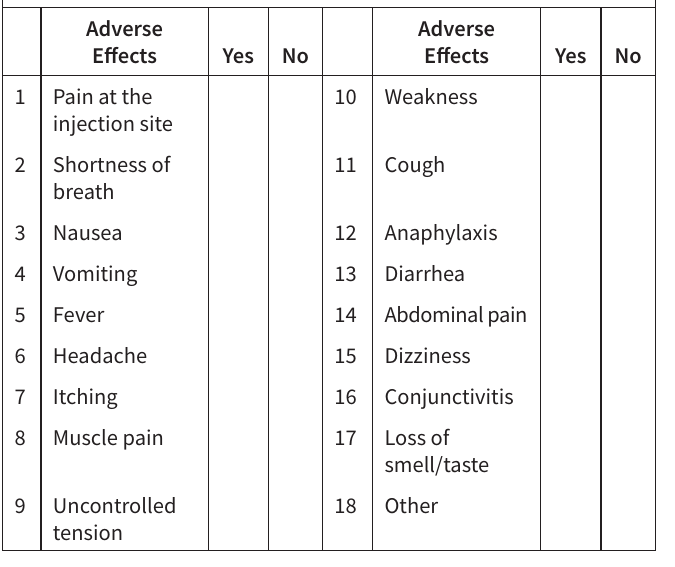
Table 2. Side Effects of COVID-19 Vaccines